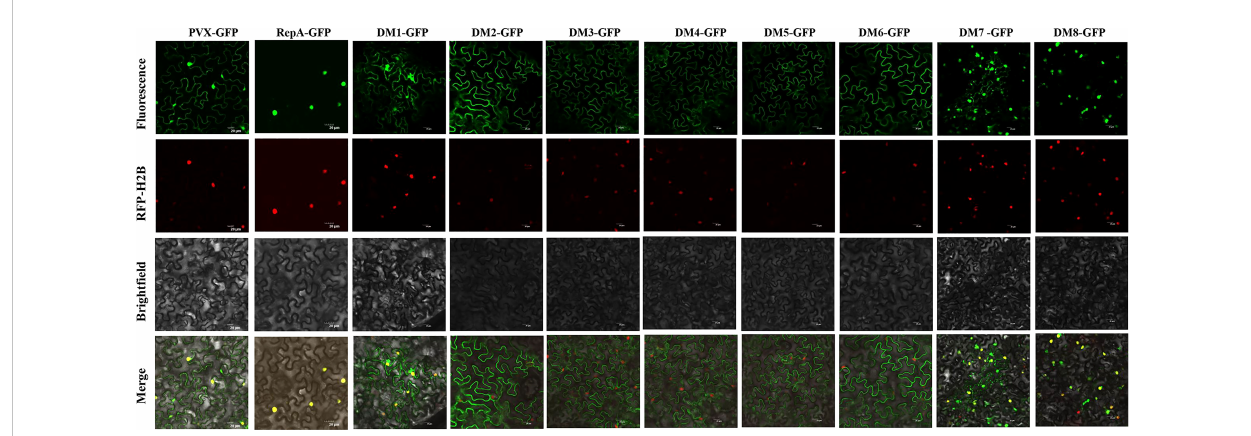
FIGURE 3 Subcellular localization analyses of CCDaV-RepA and its derivatives in Nicotiana benthamiana epidermal cells. Red fl uorescent protein-histone 2B (RFP-H2B) was co-in fi ltrated with PVX-GFP or PVX-GFP-fusion constructs into N. benthamiana leaves. Each experiment was repeated four times and at least 40 cells (average 10 cells per fi eld) were observed per plant. Scale bars = 20 µm.